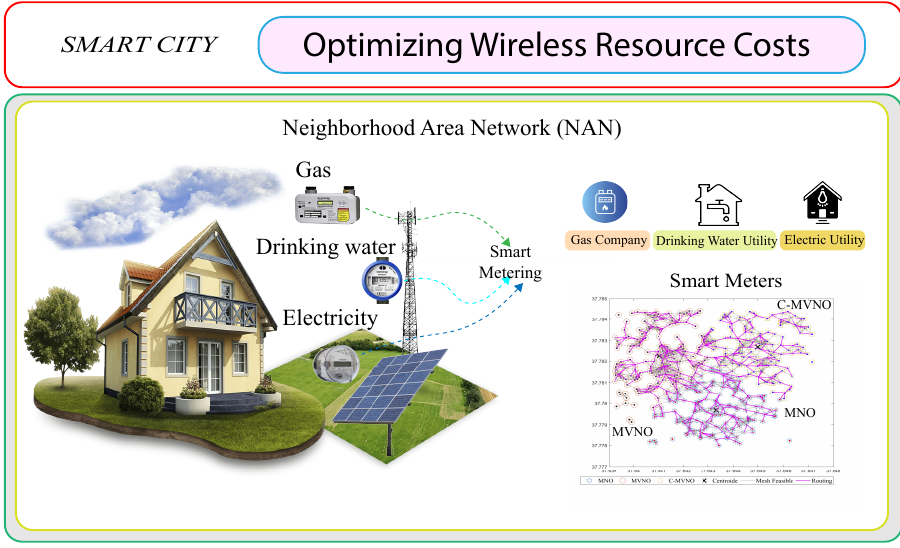
Figure 1. Process diagram of harmonic distortion detection by compressed